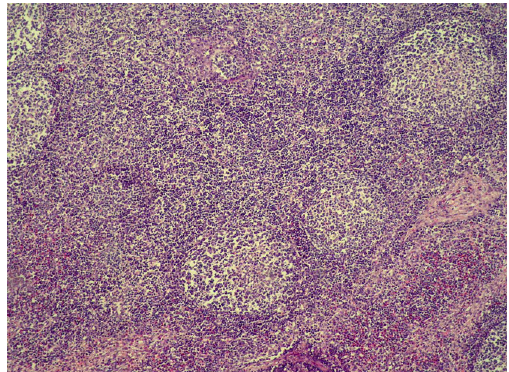
Fig. 8. Piglet lymph node, the 1 st group, the 70 th day of test. Lymphoid follicles with reactive cores in cortex. H&E. x 100